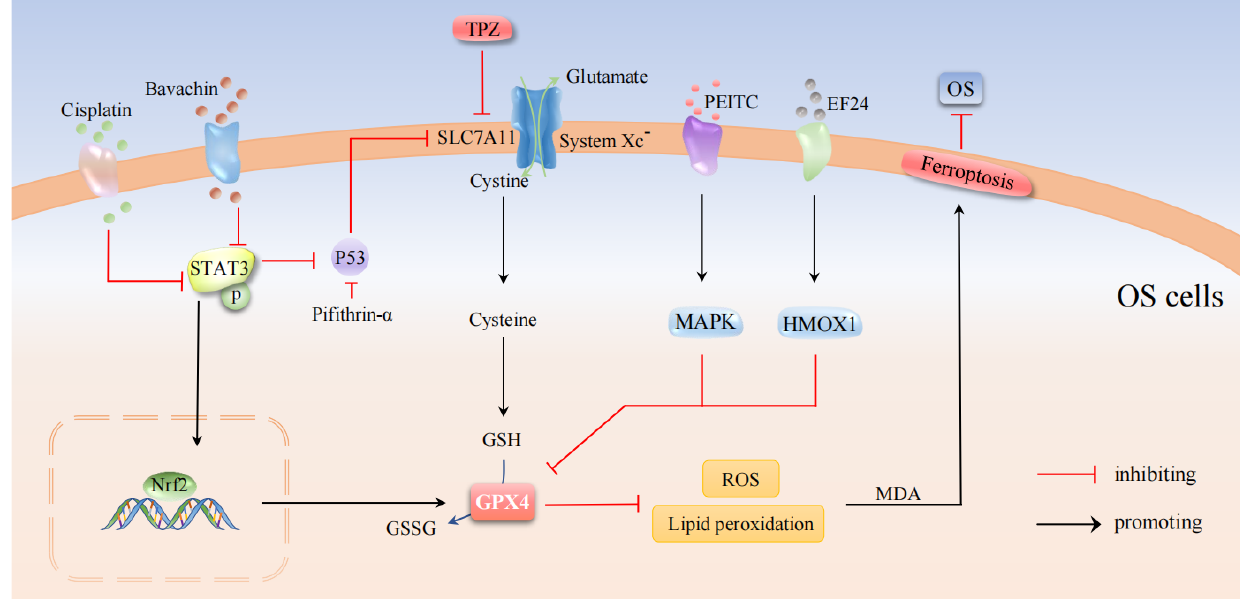
Figure 5. Molecular pathways in the regulation of osteosarcoma by ferroptosis. The anticancer drug cisplatin-induced ferroptosis by reducing STAT3 levels and increased the sensitivity of OS cells to cisplatin by inhibiting STAT3, while Bavachin also triggered OS cell ferroptosis and prevented OS cell spread by inhibiting STAT3 expression. PEITC and EF24 activated MAPK and HMOX1 signaling pathways, respectively, which can increase the lipid peroxidation level, intracellular iron concentration, and ROS level of human OS cells, thus inducing ferroptosis. TPZ induced ferroptosis in OS cells by inhibiting the expression of SLC7A11 in the classical ferroptosis signaling